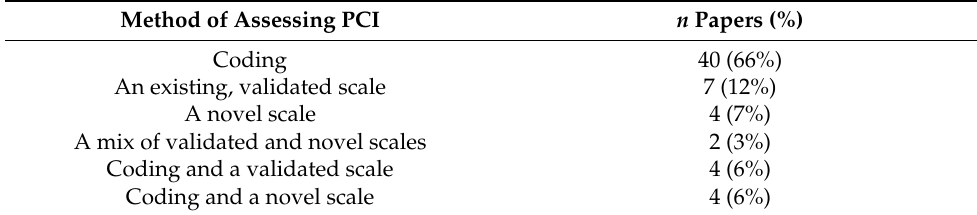
Table 2. Methods of assessing PCI between included